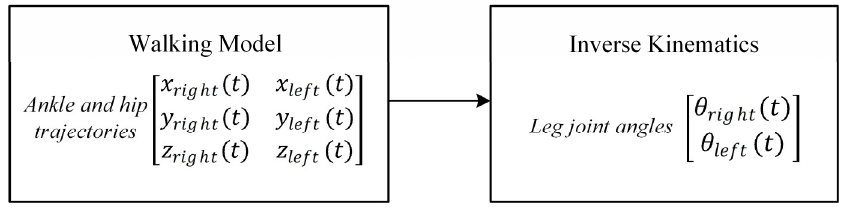
Figure 1. Walking pattern generator.